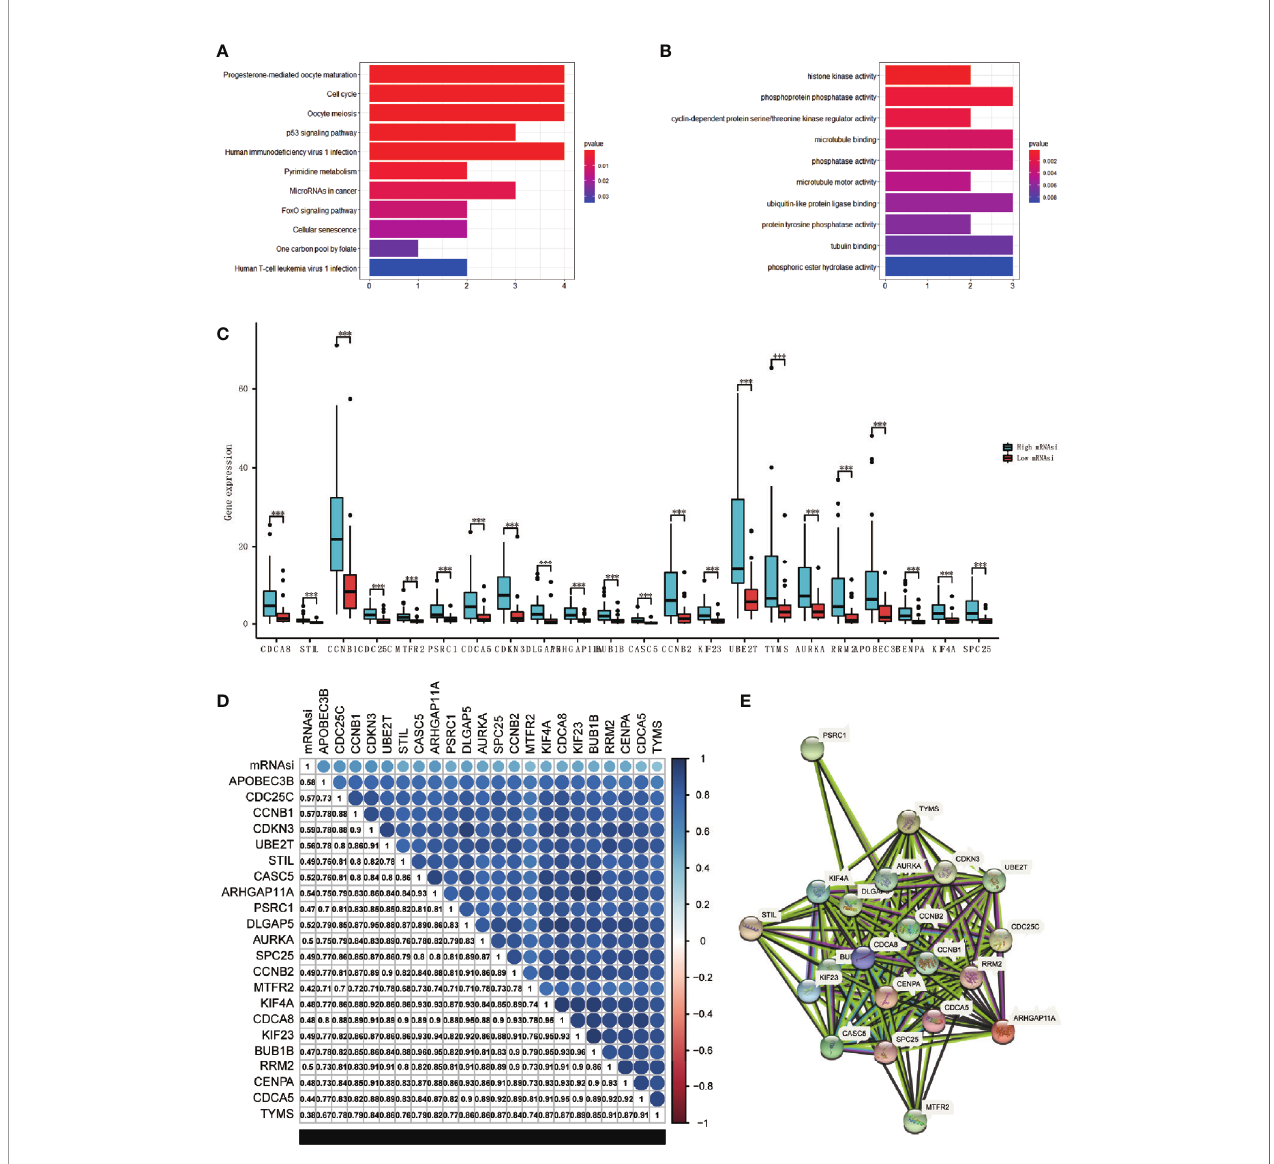
FIGURE 4 | Analysis of the main function and the correlation of hub genes. (A, B) KEGG (A) and GO (B) analysis of the hub genes. (C) Boxplot of the differential analysis of the expression of 22 hub genes between high-mRNAsi and low-mRNAsi groups (***P < 0.001). (D) Correlation analysis between 22 hub genes, correlation coef fi cient have been shown (P < 0.05). (E) The protein-protein interactions between the hub